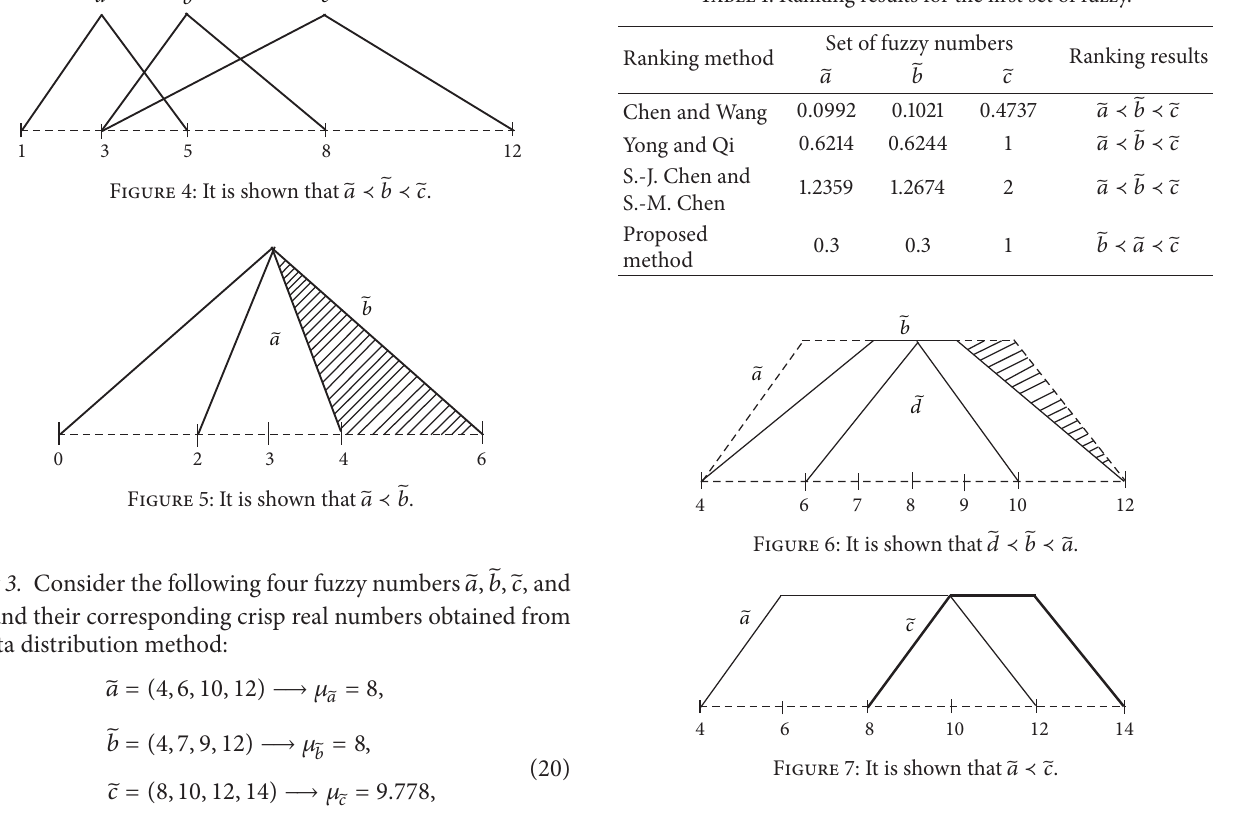
Table 1: Ranking results for the first set of fuzzy.